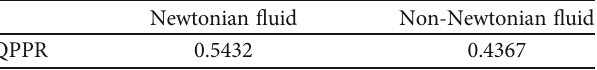
F IGURE 5: Pressures at both ends of the stenosis with the non- Newtonian fl uid model. T ABLE 1: QPPR with different fl uid models.